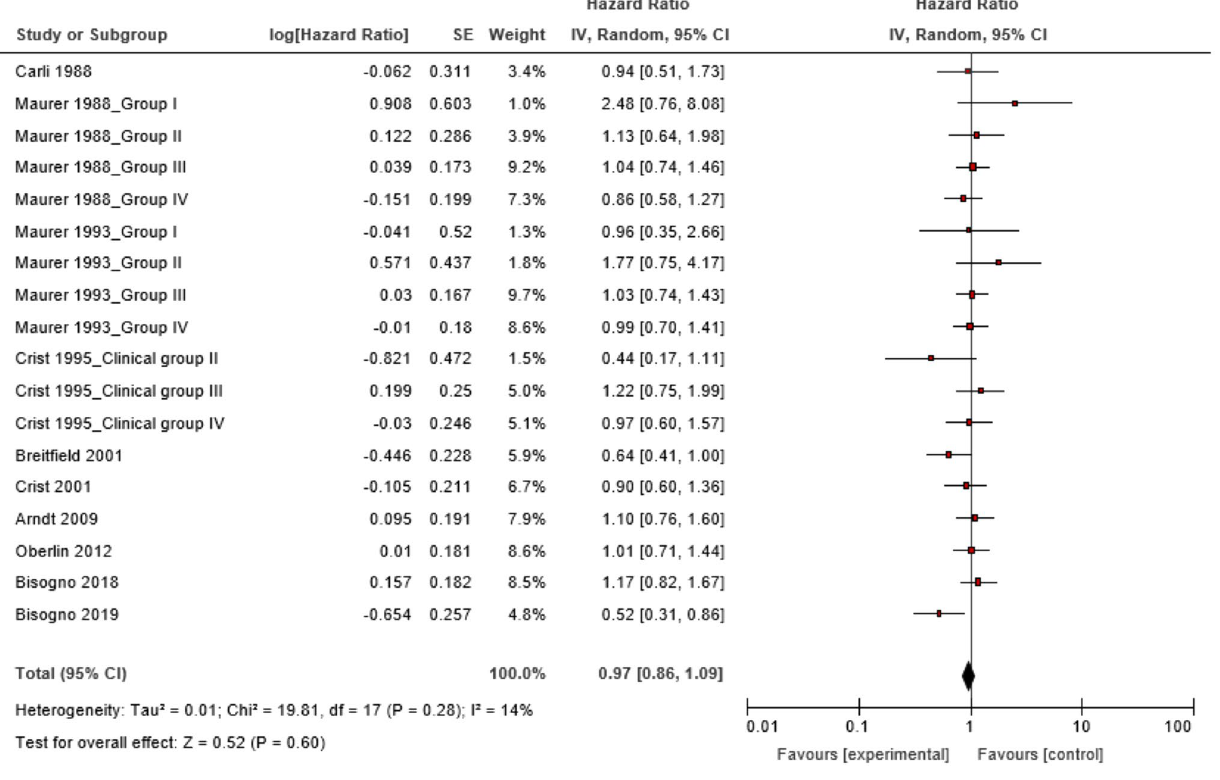
Figure 2. Forest plots of the hazard ratios (HR) for the overall survival (OS) and 95% confidence interval (CI) according to treatment effect sizes.